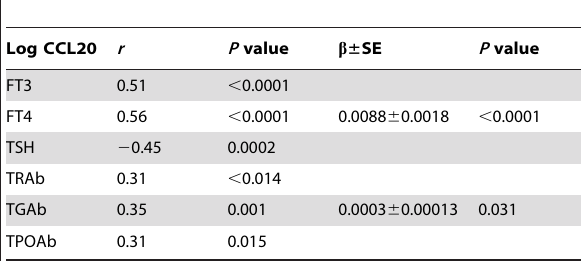
Table 2. Pearson’s correlation and multiple stepwise linear regression analysis of CCL20 associated with classic GD diagnostic